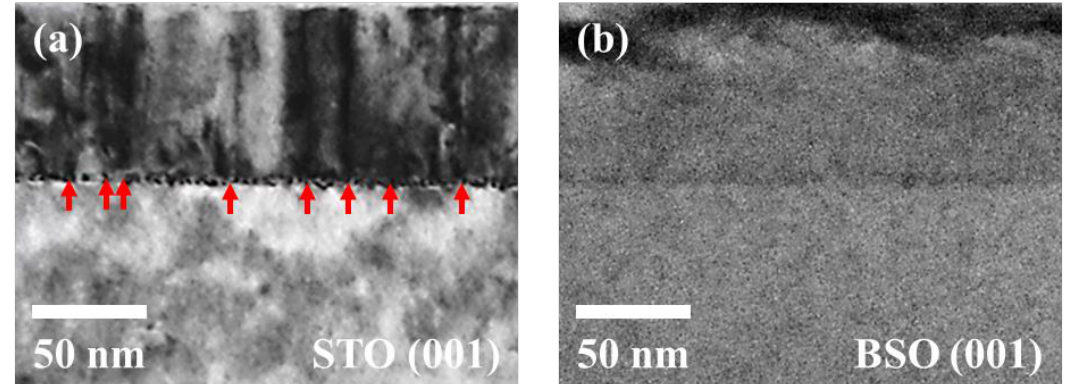
Figure 2. Transmission electron microscope (TEM) images of Ba 0.96 La 0.04 SnO 3 film deposited on ( a ) STO (001) and ( b ) BSO (001) substrates. Red arrows in ( a ) indicate the TDs.